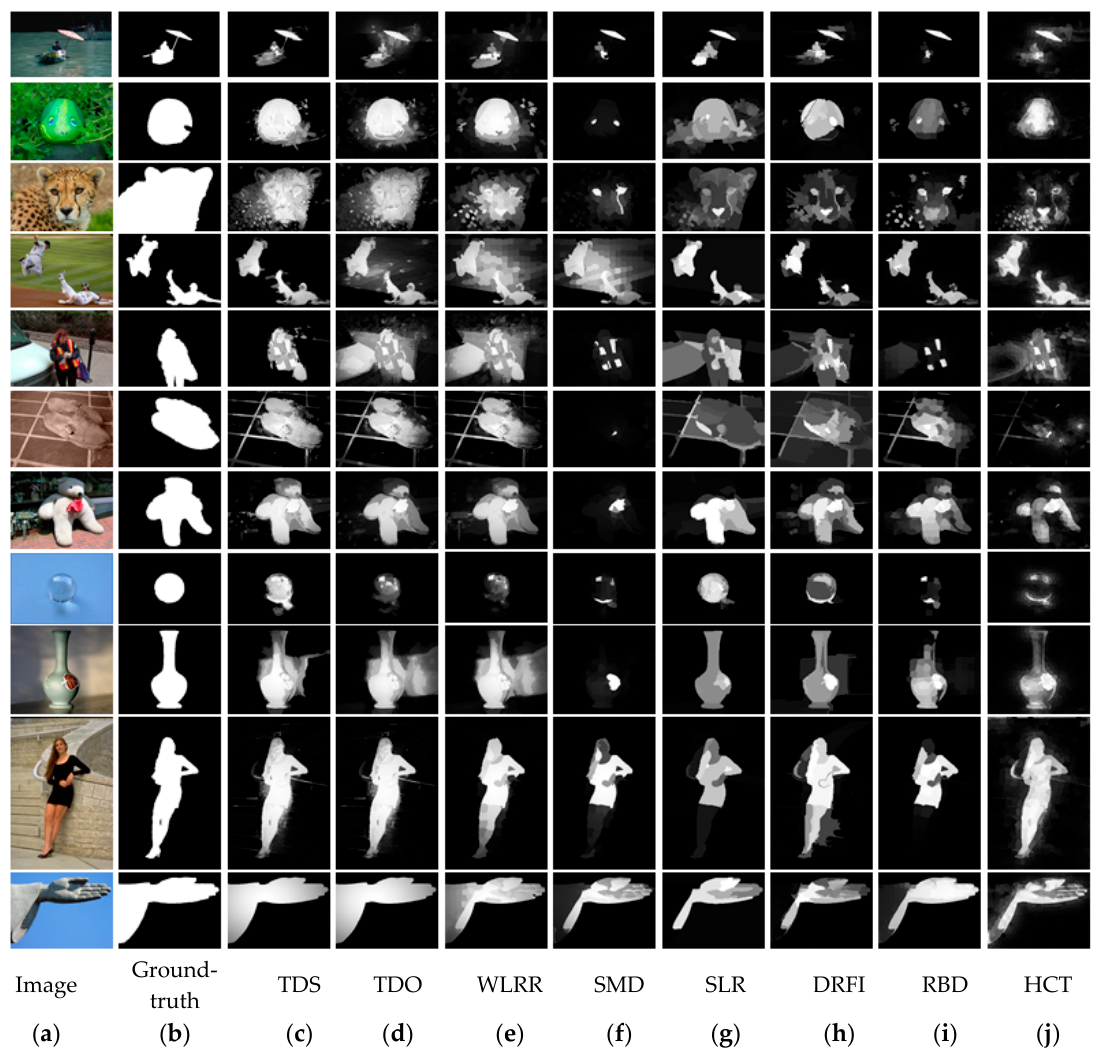
Figure 4. Visual comparison of saliency maps of different methods. ( a ) Image; ( b ) ground-truth; ( c )